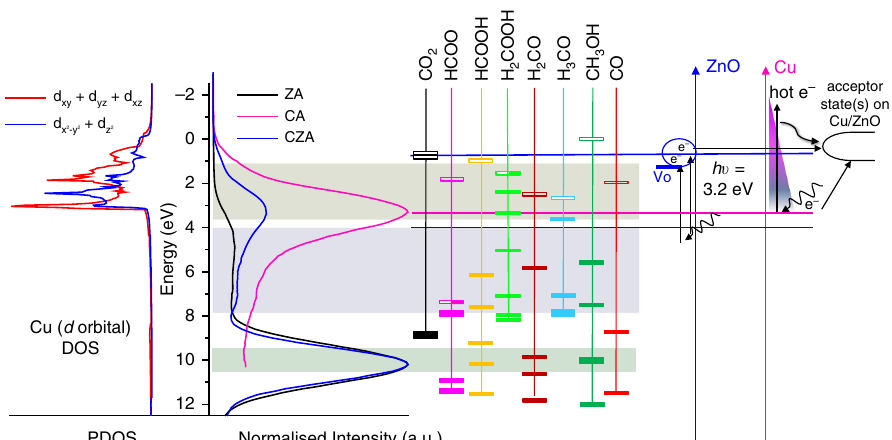
Fig. 3 Alignment of gas phase adsorbate orbital levels. In order to compare the calculated orbital energies with the experimental spectra, the calculated orbital energies were aligned such that all share a common vacuum level. The Fermi levels of Cu 3 d DOS and all reaction intermediates are aligned to the CZA Fermi level using a catalyst work function value of 4.7 eV, typical of ZnO and Al 2 O 3 . The aligned orbital levels and the experimental valence band spectra are depicted, hence E = 0 eV corresponds to the CZA Fermi level with the common vacuum level at − 4.7 eV (not shown). The electron-excitation under irradiation and its transfer to surface acceptor states in ZnO and schematic depiction of LSPR-induced indirect/direct hot electron transfer from Cu to